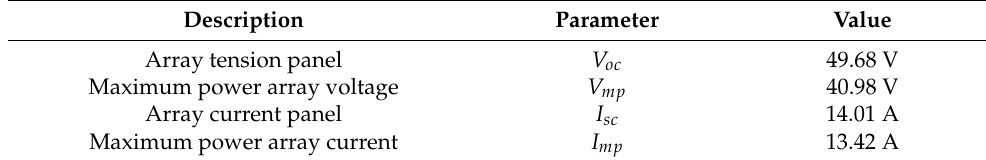
Table 1. Photovoltaic panel parameters.